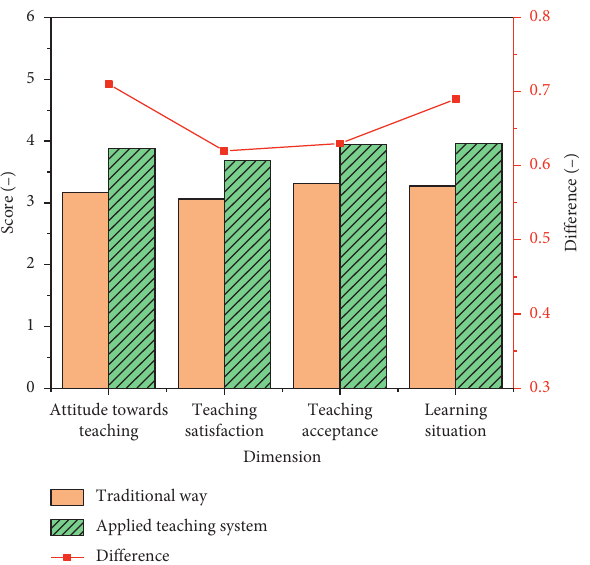
Figure 14: Statistics of average scores and differences in the 4 dimensions of I&P teaching.